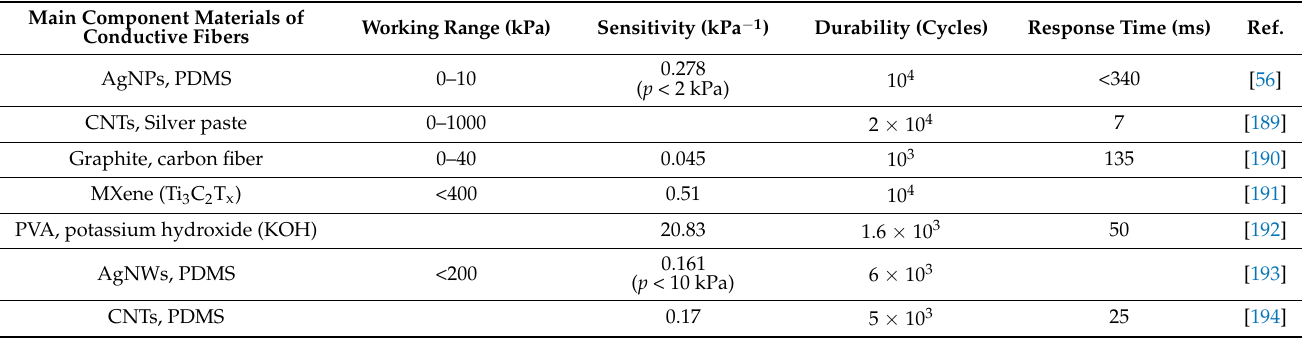
Table 4. Performance data sheets for some capacitive pressure